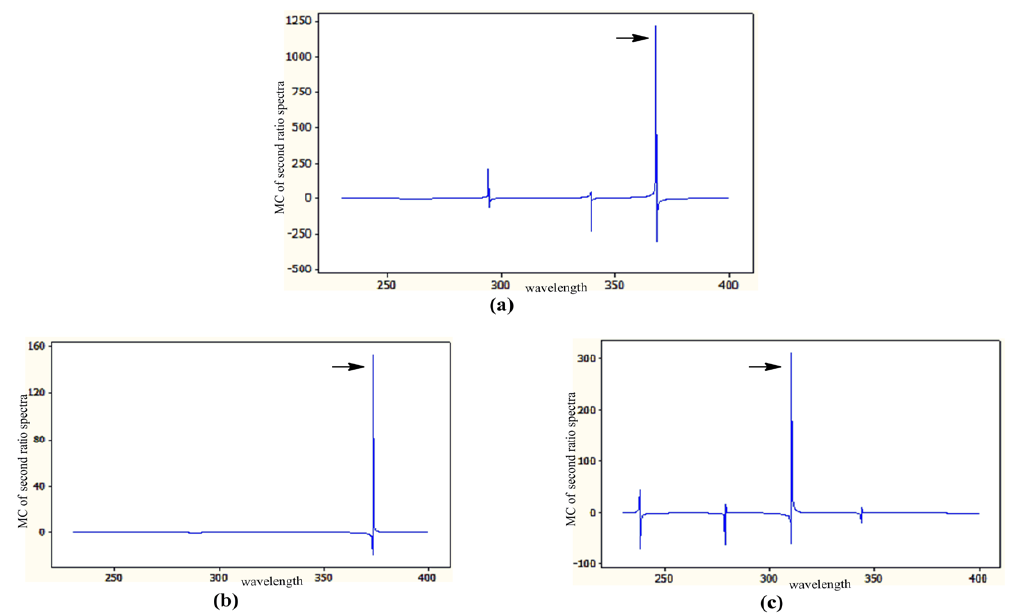
Figure 3. Mean center of second ratio spectra obtained for ( a ) CS at 367.8 nm, ( b ) Deg1 at 373.8 nm and ( c ) Deg2 at 310.6 nm.